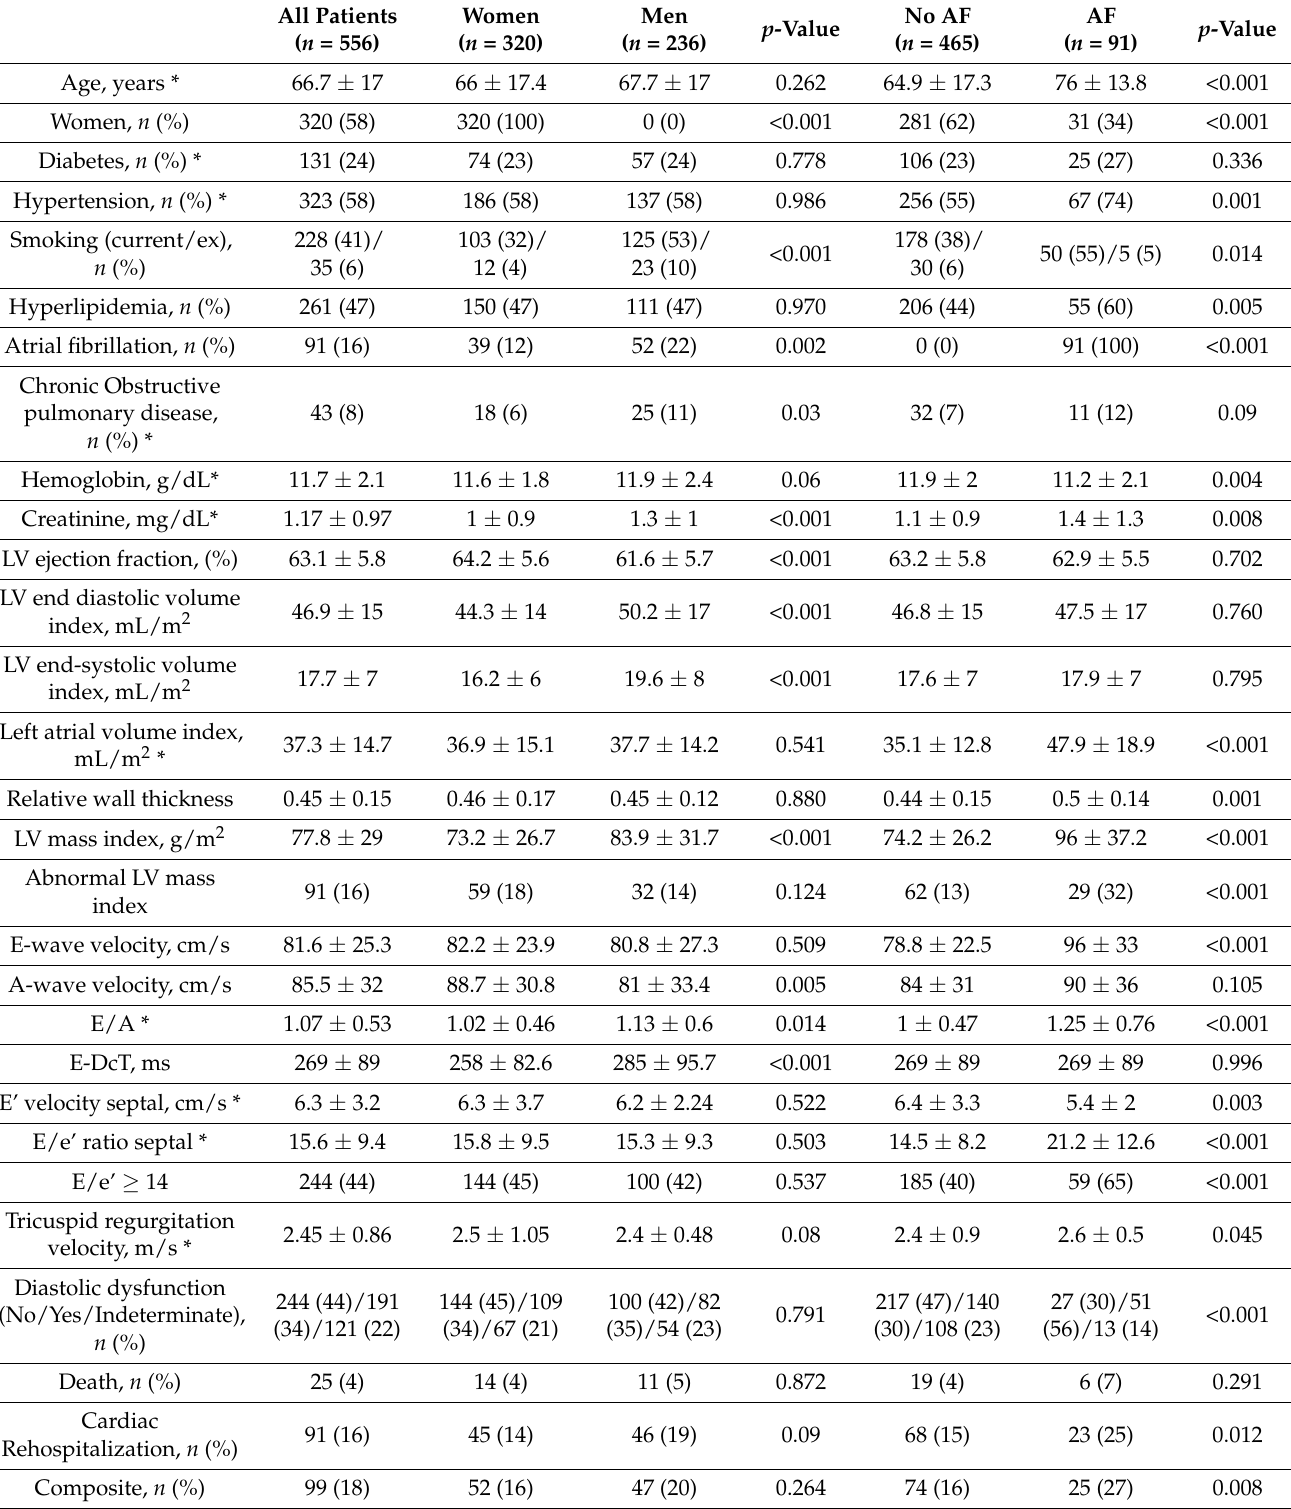
Table 1. Demographic, clinical and echocardiographic data in all patients as well as in